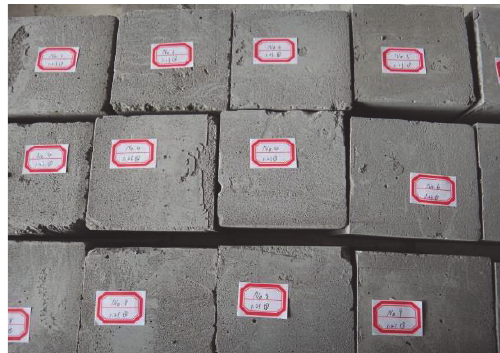
Figure 4: Different mixture proportion of FMLSF which have been